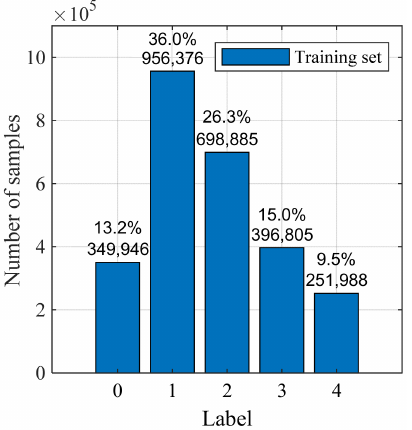
Figure 6. Distribution of damage states in the training